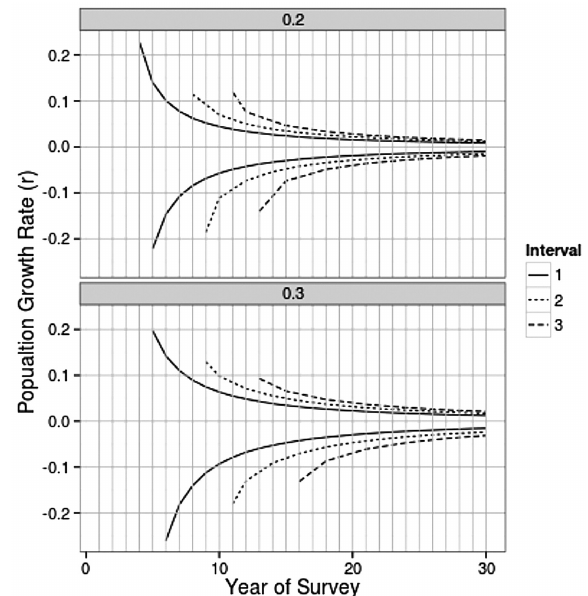
Fig. 5. – Power analysis: contours correspond to a probability of 0.6 that the null hypothesis (i.e. no change in the population) will be rejected when the null hypothesis is false. Panels correspond to the assumed CV of the survey abundance estimate (0.2 and 0.3) and lines to annual, biennial and triennial survey cycles. Horizontal lines correspond to a given population growth rate and where this inter- cepts a power curve the number of years required before a change in the population is detectable can be read off the